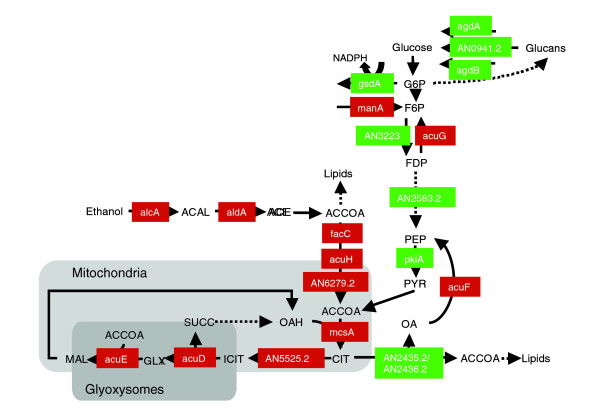
Small subnetwork identified for the shift from glucose to ethanol as carbon source. Genes marked red are upregulated and genes marked green are downregulated upon the shift. The metabolic map is simplified (many transport reactions are not included and the two steps of the glycoxylate pathway [encoded by the genes acuD and acuE] are placed in the mitochondria even though they are really located in the glyoxysomes). Conversions that involve several steps are indicated by dashed arrows. The metabolites are as follows: ACCOA, acetyl-CoA; ACE, acetate; ACHO, acetaldehyde; CIT, citrate; F16BP, fructose 1,6-bisphosphate; F6P, fructose 6-phosphate; G6P, glucose 6-phosphate; GLY, glyoxylate; ICIT, isocitrate; MAL, malate; OAA, oxaloacetate; PEP, phosphoenolpyruvate; PYR, pyruvate; SUC, succinate.